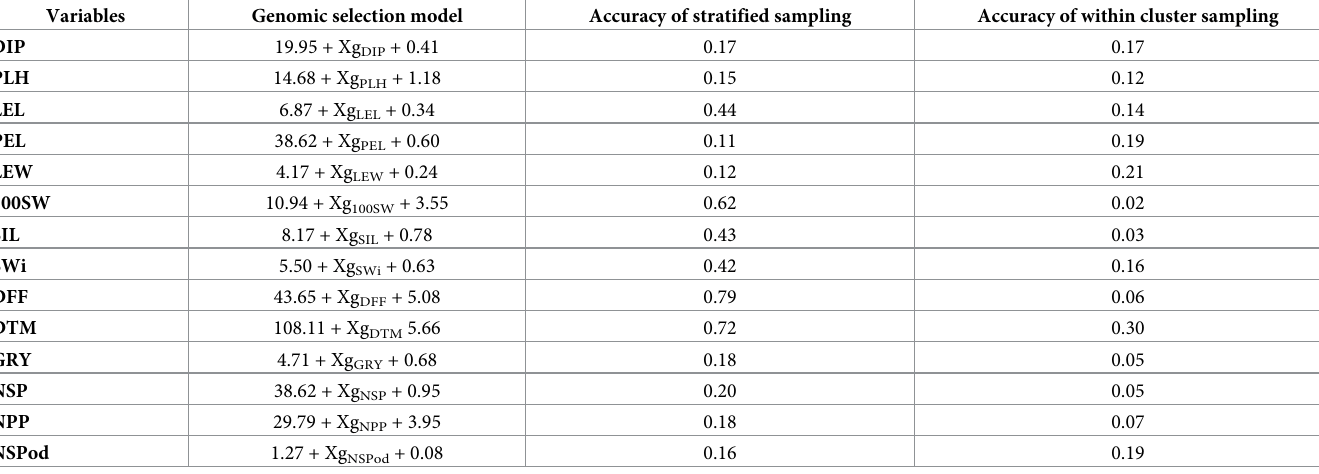
DIP = diameter of plant (cm), PLH = plant height (cm), LEL = leaflet length (cm), LEW = leaflet width (cm), PEL = petiole length (cm), 100SW = 100 seed weight (g), SIL = seed length (mm), SWi = seed width (mm), STh = seed thickness (mm), DFF = days to 50% flowering (days), DTM = days to maturity (days), GRY = grain yield (g/plant), NSP = number of seeds per plant, NPP = number of pods per plant, NSPod = number of seeds per pod, X = SNP markers, g = SNP markers